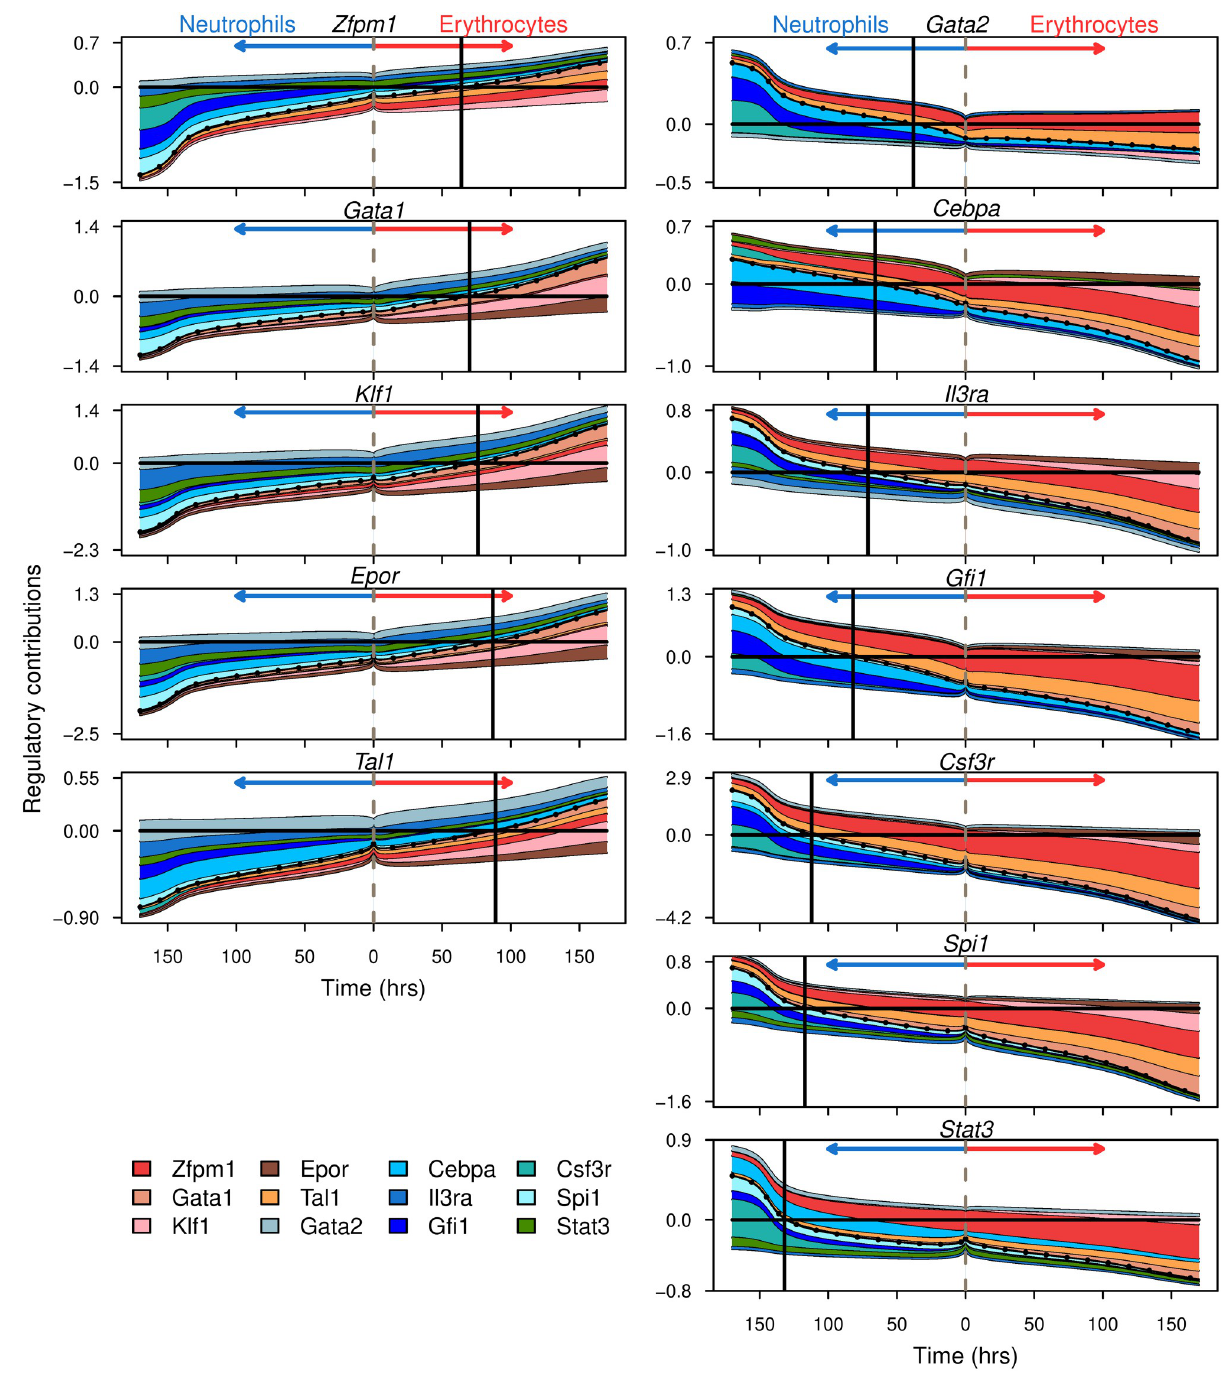
Fig 6. The dynamics of gene regulation during differentiation. The total regulatory input ( u ) is plotted as the dotted black line. The colored layers show the regulatory contribution of individual regulators. See Section 4 for the definitions of total regulatory input and regulatory contributions. The contributions of repressors and activators are shown above and below the dotted line respectively. The vertical dashed line in the center corresponds to uninduced FDCP-mix cells at the start of differentiation. Regulatory contributions during erythrocyte and neutrophil differentiation are shown to the right and left of the dashed line respectively. The vertical black line marks the time when the total regulatory input crosses zero so that synthesis occurs at half its maximum rate (Section 4).